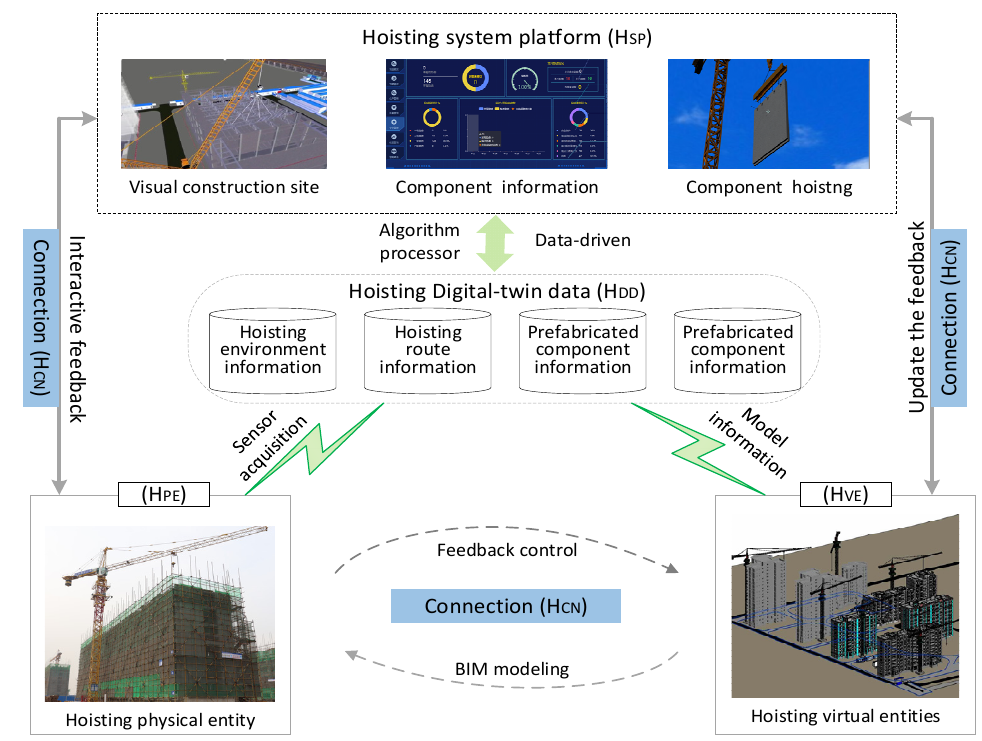
Figure 1. DT five-dimensional model for PC hoisting management.